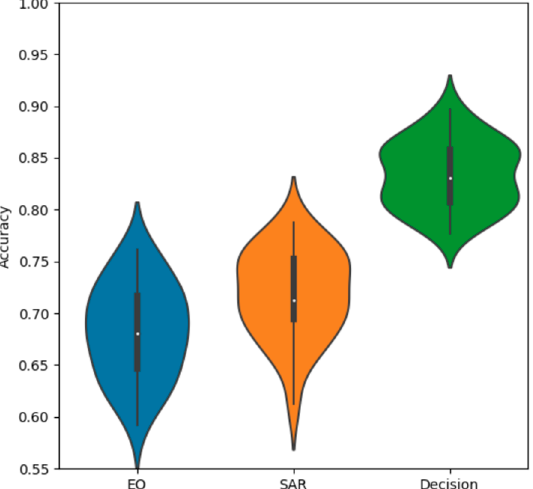
Figure 17. Accuracy distributions of simple net decision fusion vs. SAR and EO.